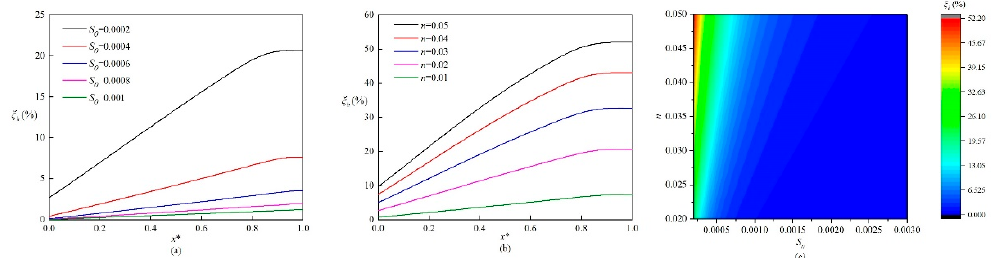
Figure 3. The influence of geometrical factors on the relative error ξ h . ( a ) S 0 varied between 0.0002 and 0.001 with n = 0.02, Q bottom = 100 m 3 s − 1 , Q peak = 500 m 3 s − 1 , T peak = 8 h, and a = 1.1. ( b ) n varied between 0.01 and 0.05 with S 0 = 0.0002, Q bottom = 100 m 3 s − 1 , Q peak = 500 m 3 s − 1 , T peak = 8 h, and a = 1.1. ( c ) The joint influences of manning coe ffi cient and slope while S 0 varied from 0.0002 to 0.003 with the interval of 0.0001 and n varied from 0.02 to 0.05 with the interval of 0.001 (all the possible tests according to the selected value of every parameters were calculated), and the value of hydraulic factors is same as ( a